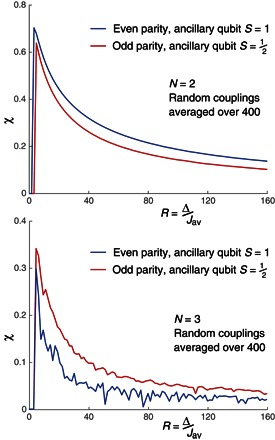
Scaling of the minimum gap.Minimum gap ratio between the physical and logical systems as a function of the constraint’s strength. The even- and odd-parity variants perform differently, especially in the N = 3 case, as discussed in the text.